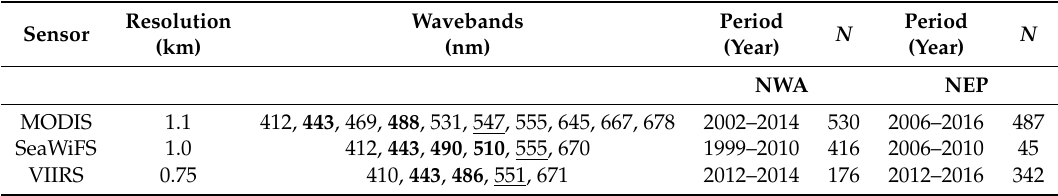
Table 1. Specifications of sensors and matchup datasets. Bold and underlined numbers correspond to blue ( λ blue ) and green ( λ green ) bands used in the band ratio Ocean Colour X (OCx) algorithms respectively (see Section